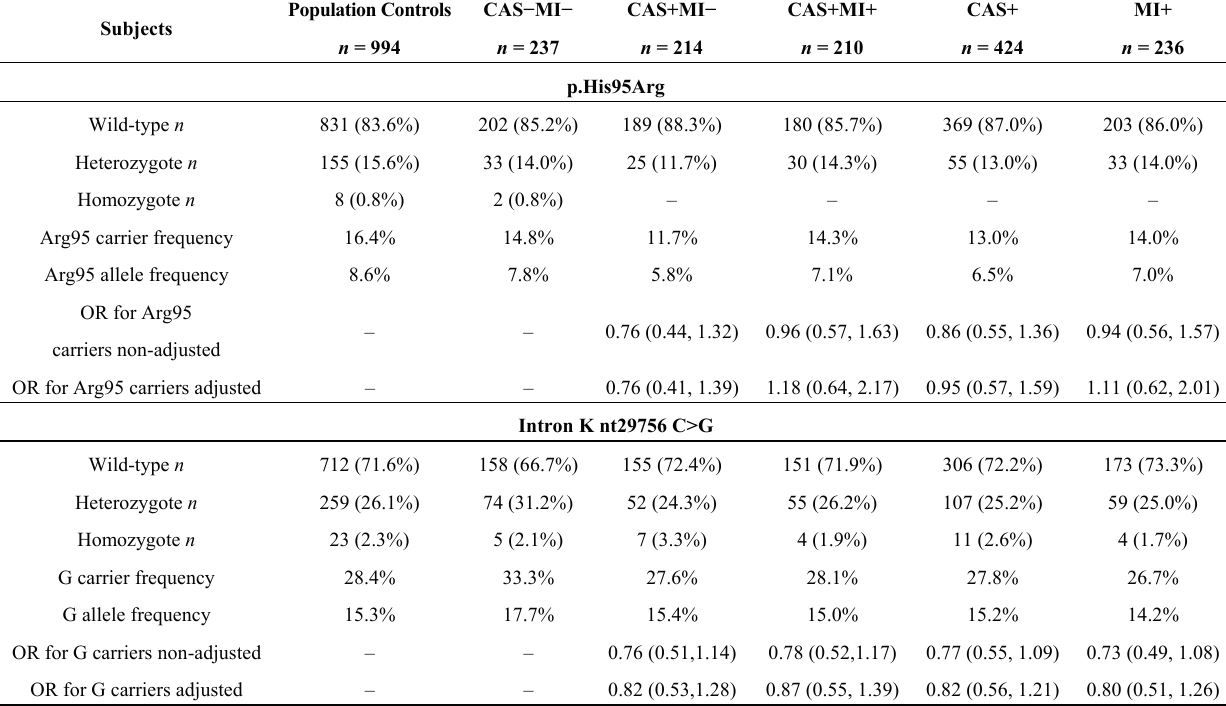
Table 2. FXIII-B p.His95Arg and intron K nt29756 C>G genotype distribution in control and patient groups; the effect of polymorphisms on the risk of coronary artery